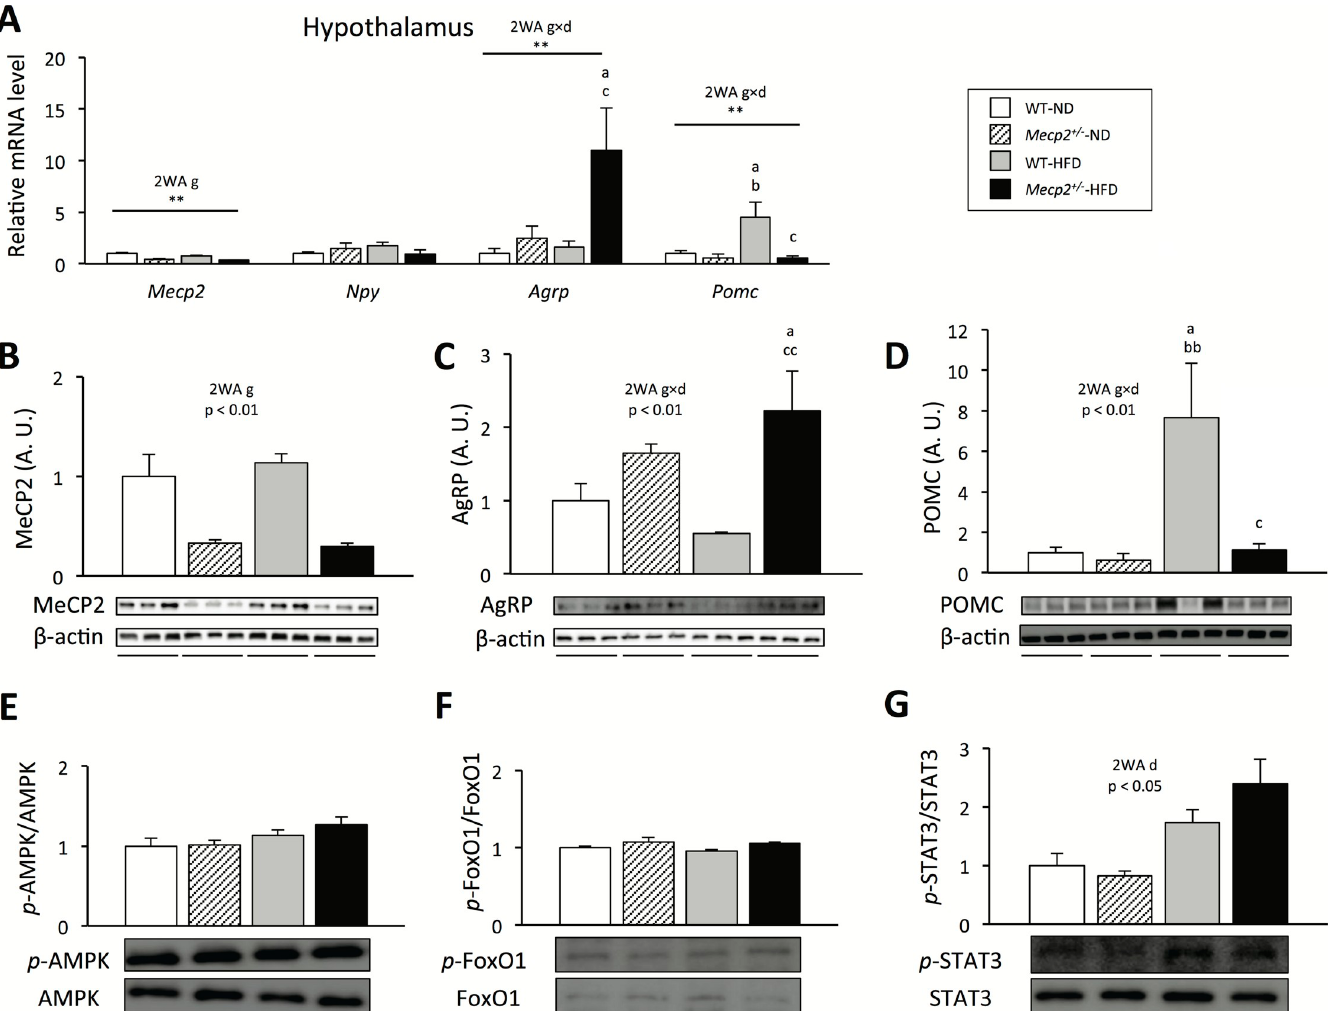
Fig 4. Hypothalamic dysregulation of food intake in Mecp2 +/- mice. (A) mRNA expression levels of food intake regulation-related genes in the hypothalamus, determined using qPCR. (B) MeCP2, (C) AgRP, and (D) POMC protein expression in the hypothalamus, determined using western blot analysis. Phosphorylation of (E) AMPK, (F) FoxO1, and (G) STAT3 in the hypothalamus, using western blot analysis. (A–F) Mice were tested at 16 weeks of age; values are the mean ± SE for 5 mice. �� = p < 0.01, a p < 0.05, vs. WT mice fed a normal chow diet (WT-ND). b p < 0.05, bb p < 0.01 vs. Mecp2 +/- mice fed a normal chow diet ( Mecp2 +/- -ND). c p < 0.05, cc p < 0.01 vs. WT mice fed a high-fat diet (WT-HFD). 2WA = Two-way ANOVA, g = genotype, d = diet, Two-way ANOVA followed by post-hoc Tukey-Kramer Multiple-Comparison test.